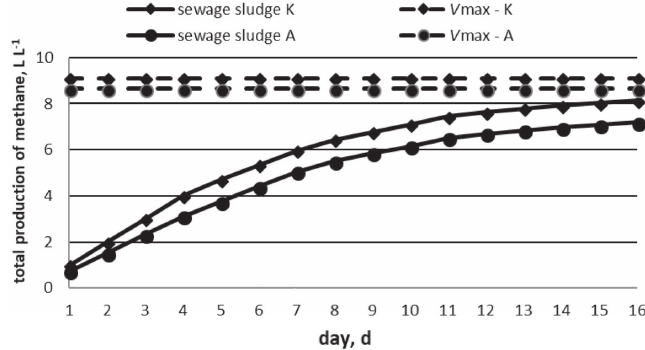
Fig. 3 – Volume of biogas produced during anaerobic diges- tion process